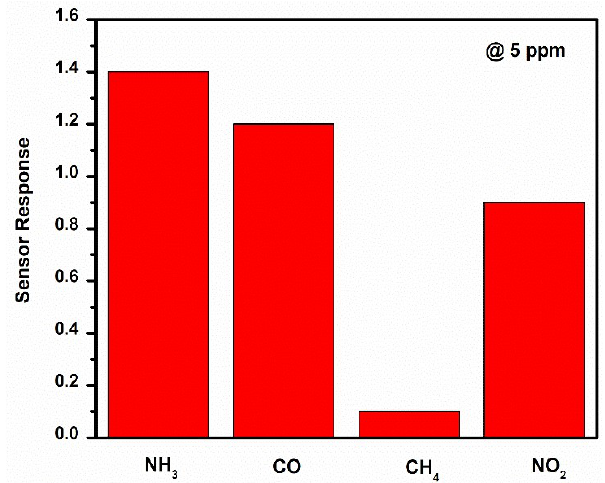
Figure 9. Selectivity studies of Zn: WO 3 toward various gases.